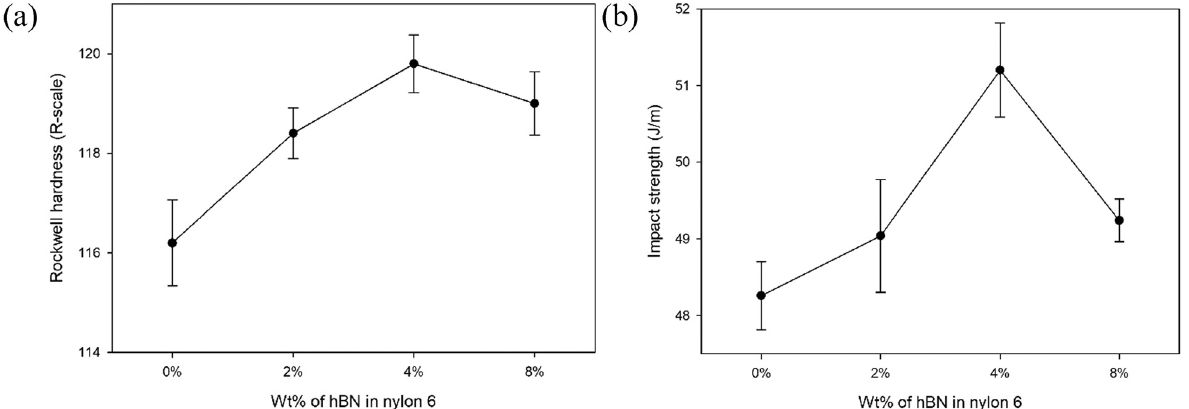
Figure 6: ( a ) Rockwell hardness ( ‘ R ’ - scale ) ; ( b ) impact strength ( J/m )